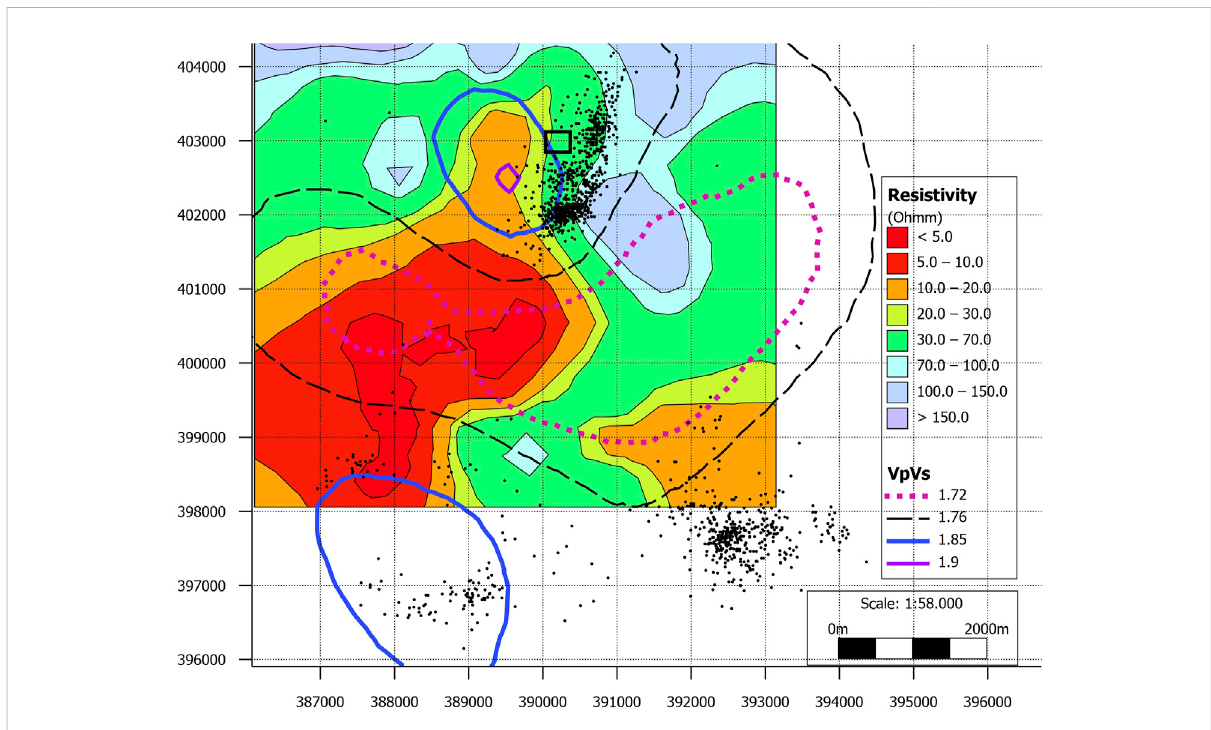
FIGURE 10 A horizontal slice at 4 km depth through the resistivity model (Vilhjálmsson et al., 2019) and the tomographic model showing v P v contours. Black dots are earthquakes, at 500 m distance from each side of the